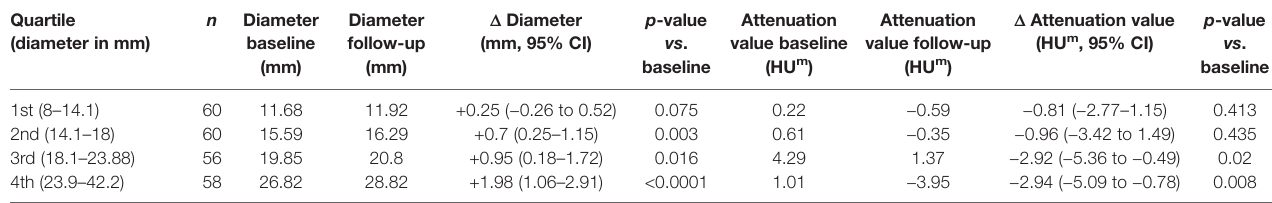
TABLE 4 | Radiological data of patients with a follow-up available CT, grouped by quartile of mean diameter (reported in the fi rst column). Quartile (diameter in mm)